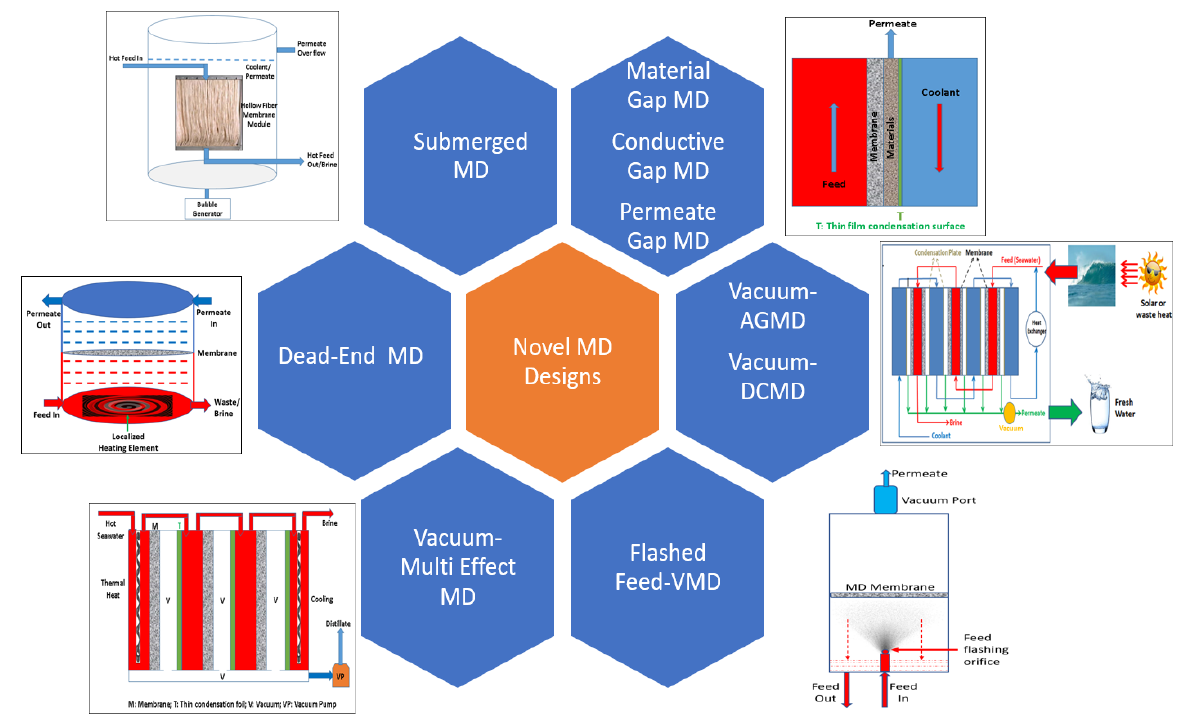
Figure 9. Novel MD module designs.